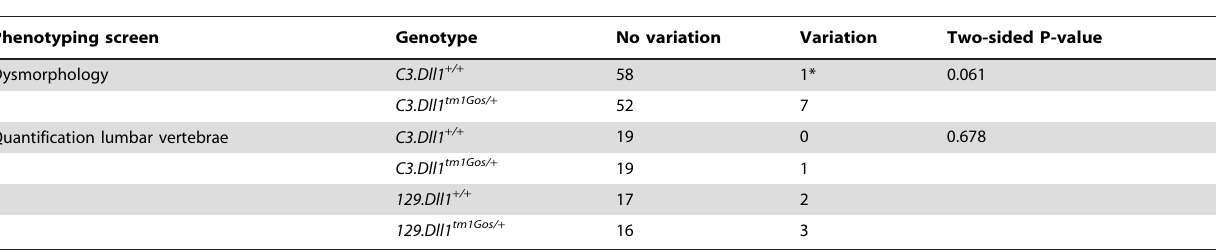
Table 2. Skeletal phenotyping of heterozygous Dll1 tm1Gos/ + animals.